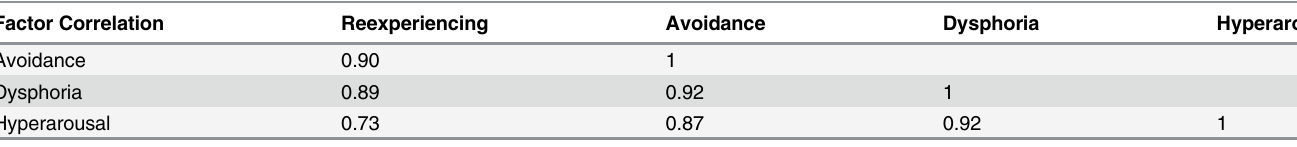
Table 3. Factor Correlations for the PTSD Dysphoria Model. Factor